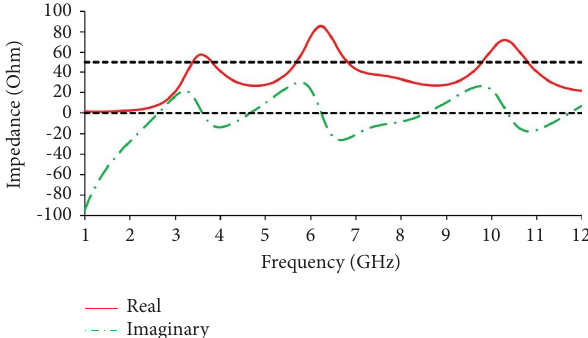
Figure 6: Real and imaginary impedance characteristics of the proposed